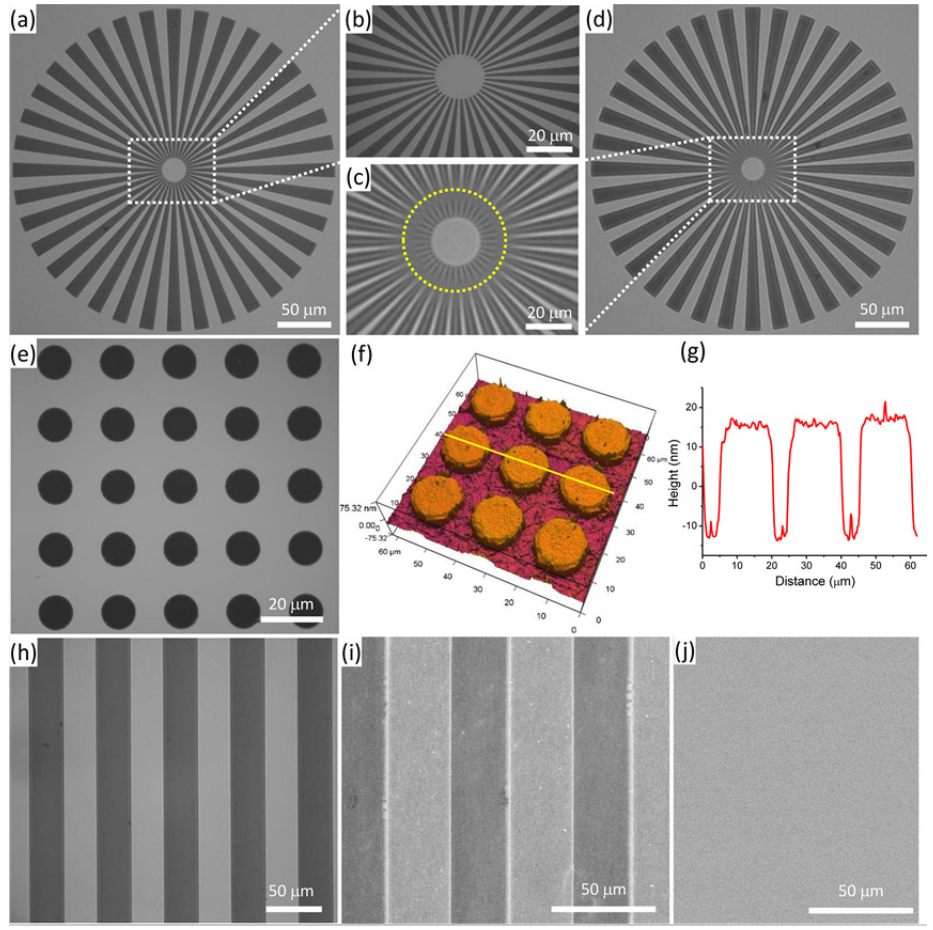
Figure 3. Mask plate of radial shape, patterned and also whole VO 2 gel/ceramic films. ( a ) is a mask plate and ( d ) is the corresponding pattern on VO 2 gel film. ( b , c ) is enlarged views of the boxed area in ( a , d ). The lines inside the circles in ( c ) can no longer be distinguished, so the lithographic resolution is evaluated to be 5 μ m. ( e – j ) are patterned or whole VO 2 ceramic films; ( e ) is a dot array with a periodicity of 20 μ m, and ( f , g ) are the results from the atomic force microscope. ( h ) is grating with a periodicity of 60 μ m; ( i , j ) are scanning electron microscope pictures for grating patterns and whole films, respectively. There is almost no difference between the patterns and films.